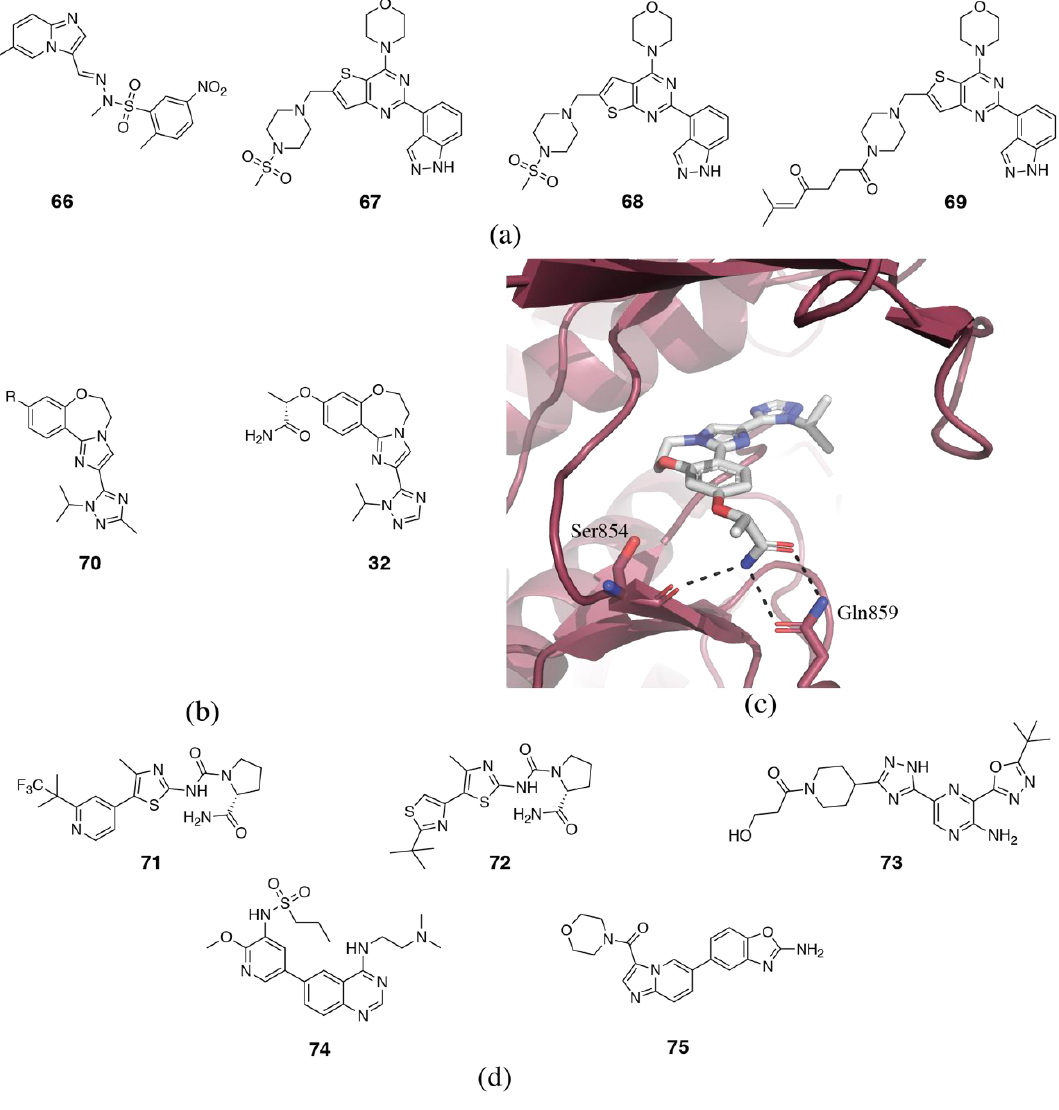
Figure 11. PI3K α selective inhibitors. ( a ) Structures of 66 – 69 . ( b ) Structures of Genentech β -sparing ( 70 ) and α -selective inhibitors ( 32 ). ( c ) 32 in complex with p110 α (raspberry, PDB ID 5DXT) showing Region 1 interactions with α Gln859 and the backbone of α Ser854. ( d ) Structures of 71 – 75 .